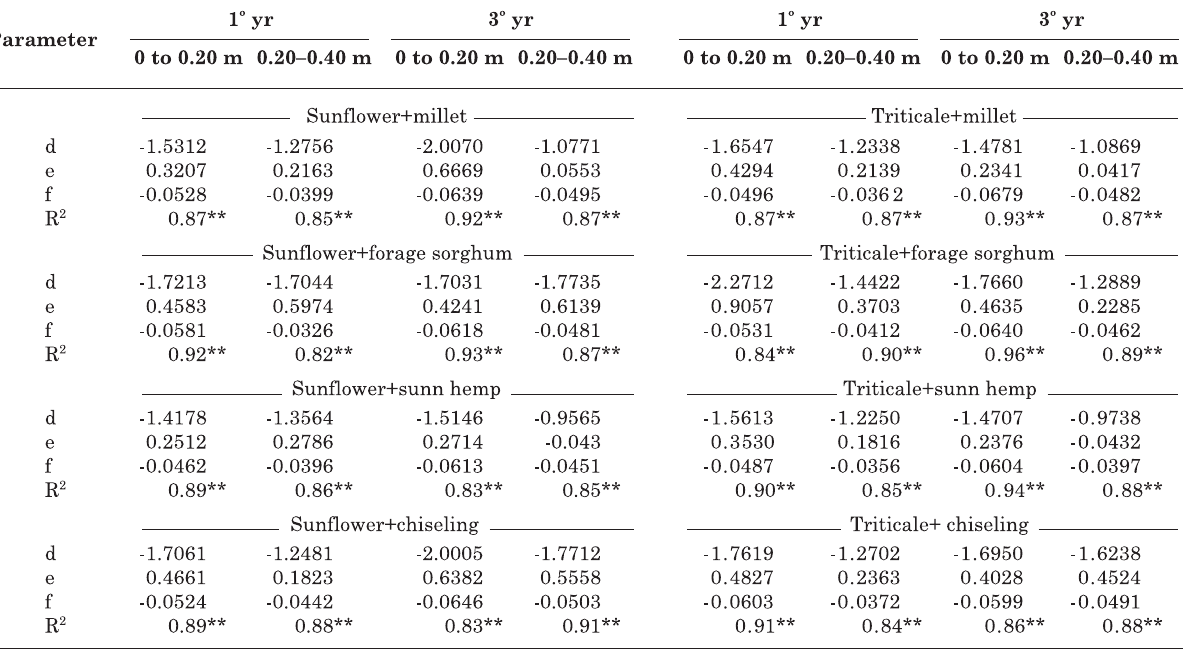
Significant at p < 0.01.